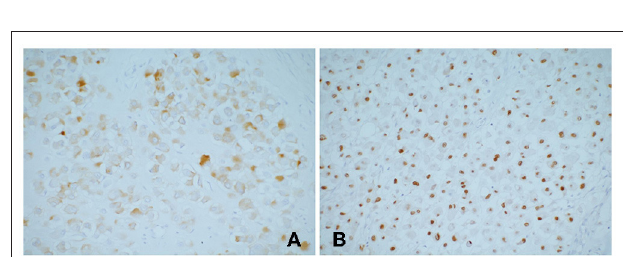
FIGURE 2 | Immunohistochemical stains showing tumor cells (A) desmin positive; (B) myogenin positive. Myogenin is highly specific and sensitive for rhabdomyosarcoma, which currently used as the standard antibody for